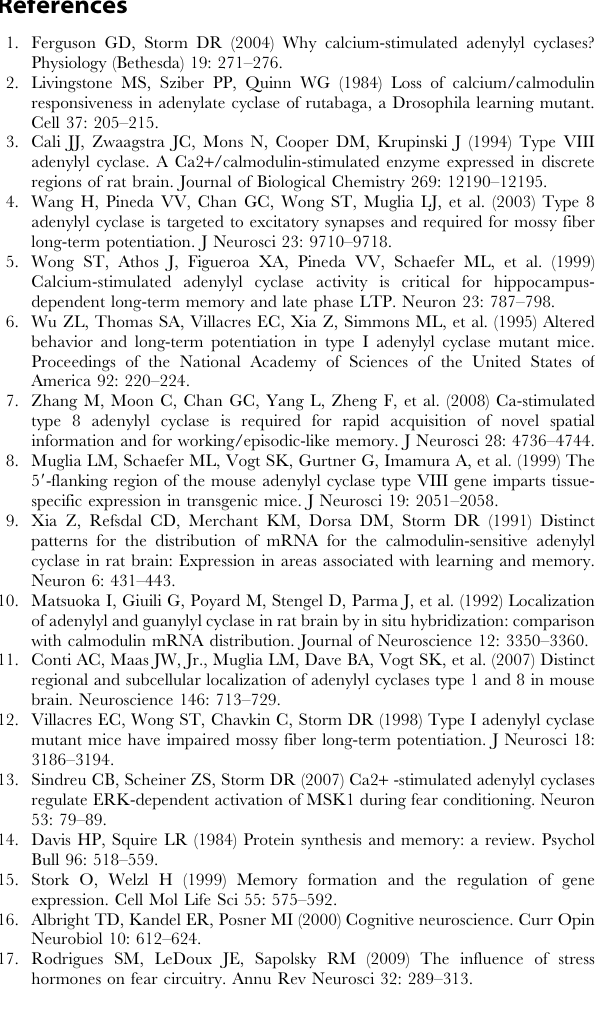
Table S7 The primer sequences used for RT-PCR analysis.